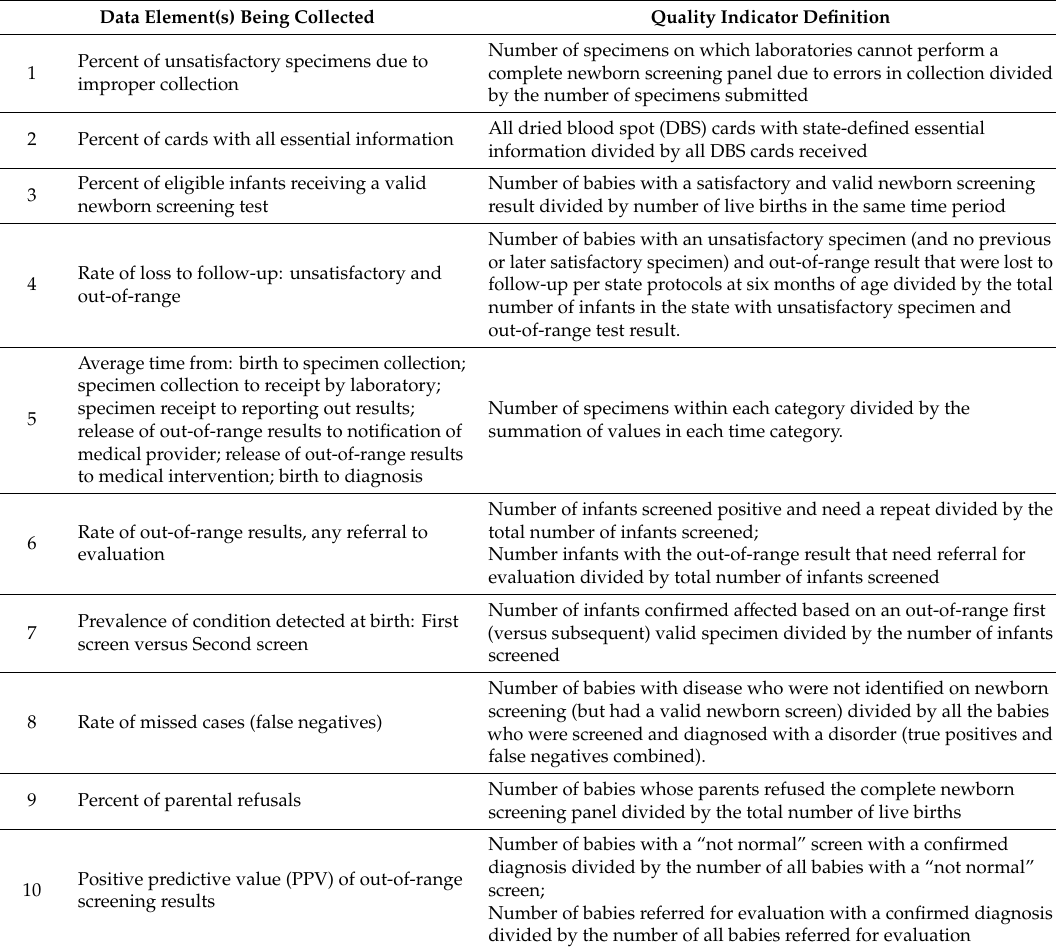
Table 2. 10 National Newborn Screening Quality Indicators, Developed June 2011